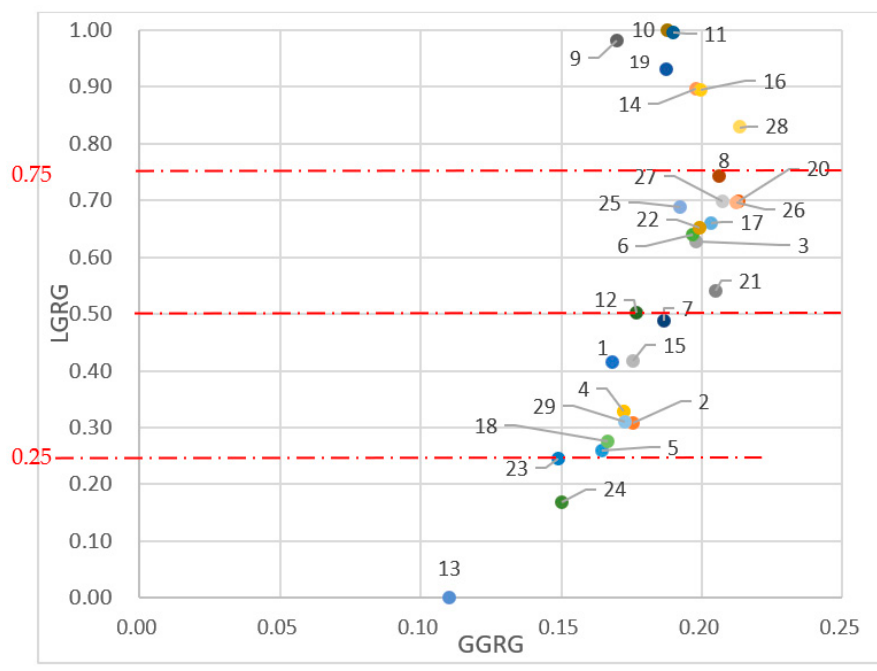
Figure 3. GSM student clustering.